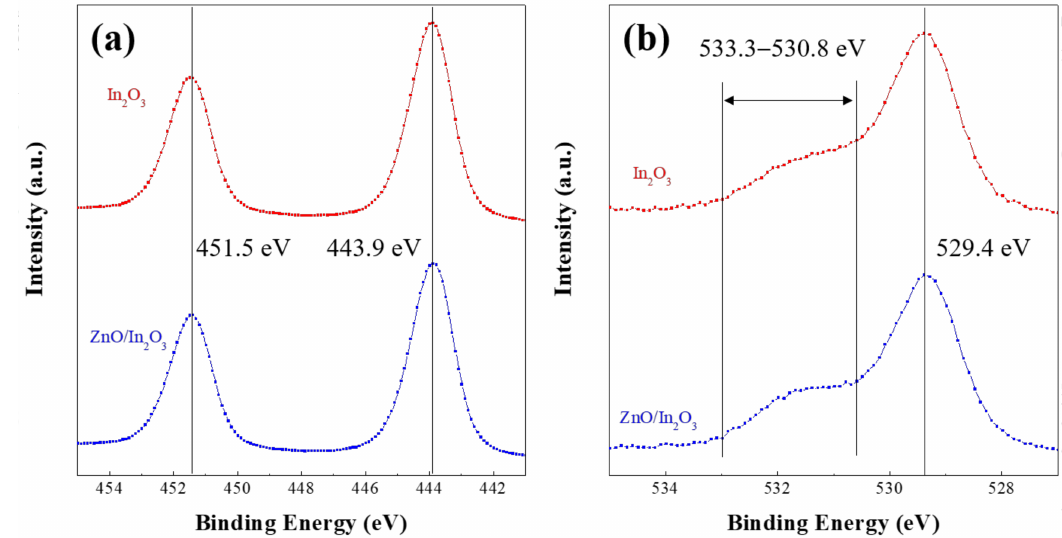
Figure 5. High-resolution X-ray photoemission spectroscopy (XPS) spectra of ( a ) In 3 d and ( b ) O 1 s orbitals in the single-layer In 2 O 3 and bilayer In 2 O 3